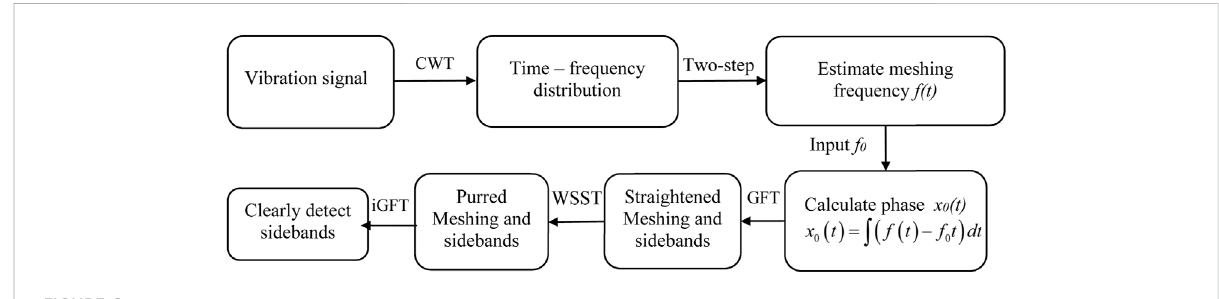
FIGURE 6 Flowchart of the proposed method.